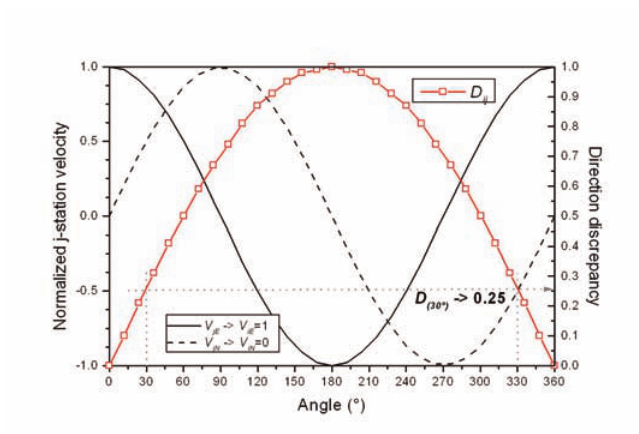
Figure 8. The D parameter shows the discrepancy level between vector V ij and V direction in the [−1, 1] interval (red squares). Abscissa: angle between j the reference velocity V = [0 1] T and V . The vector components, i.e. cosine i j and sine of the angle, are shown by solid and dashed lines